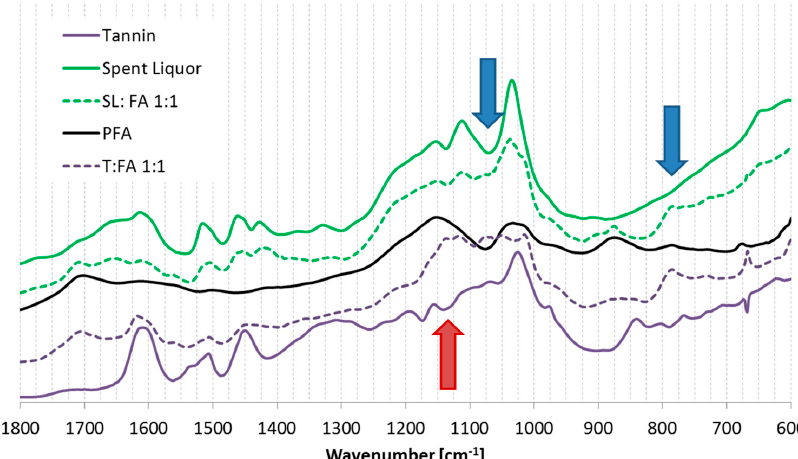
Figure 5. FT-IR spectra of spent liquor- and tannin-furanic solids: Spent liquor ( Green bold ); SL:FA 1:1 ( Green dotted ); Poly furfuryl alcohol ( Black bold ); Tannin ( Purple bold ); and T:FA 1:1 ( Purple dotted ).